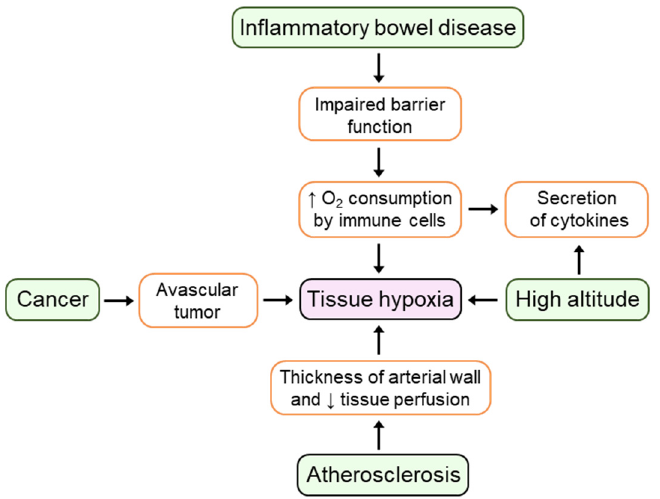
Figure 1. The presence of tissue hypoxia is common in physiology and disease.